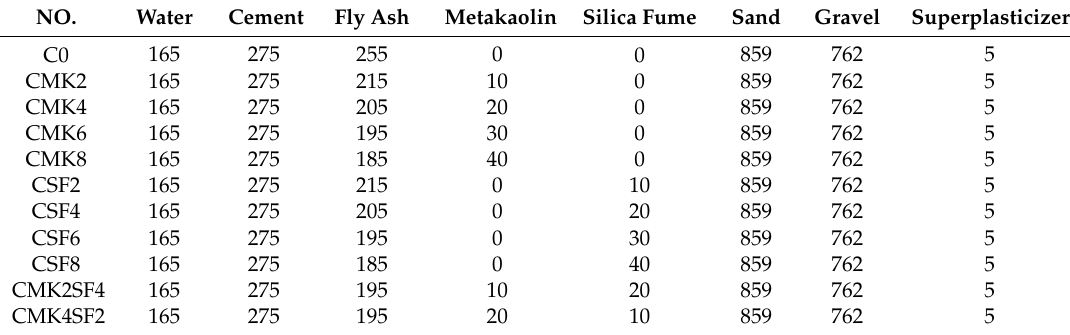
Table 3. Mix design of self-compacting concrete (SCC) (kg/m 3 ).